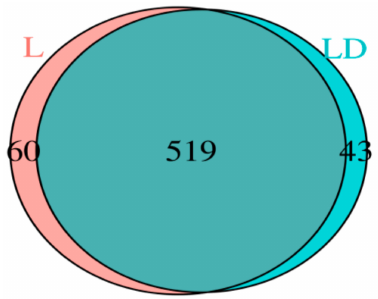
Figure 1. Venn diagram of unique and shared OTUs between L and LD